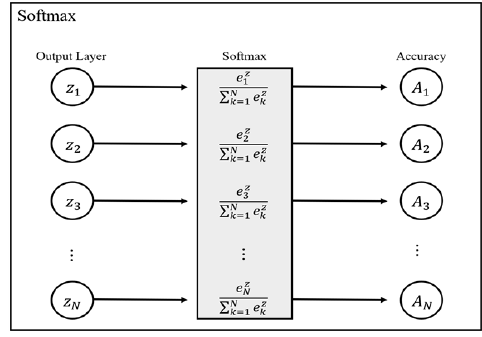
Figure 2. SoftMax